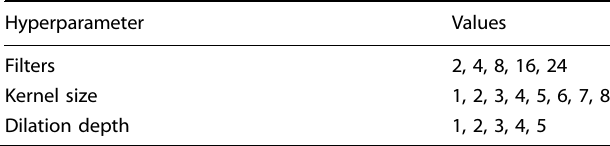
Table 1. Hyperparameter values for investigating the optimal temporal convolutional network con fi